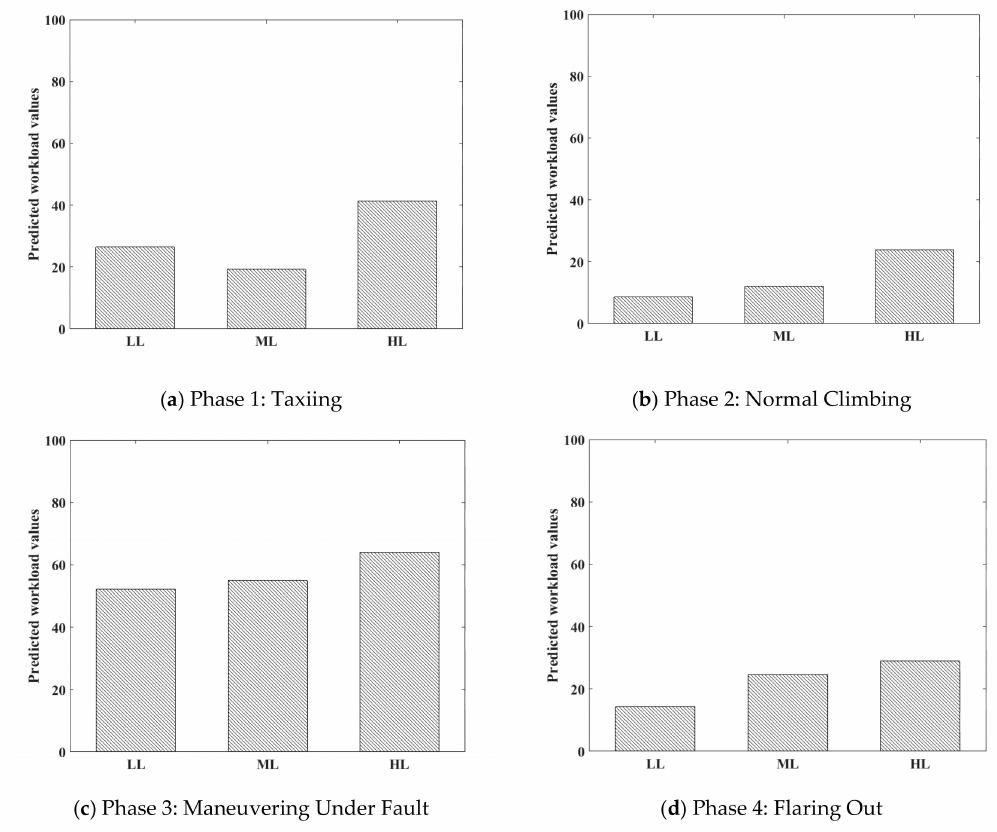
Figure 11. Mean predicted workload values under di ff erent mission di ffi